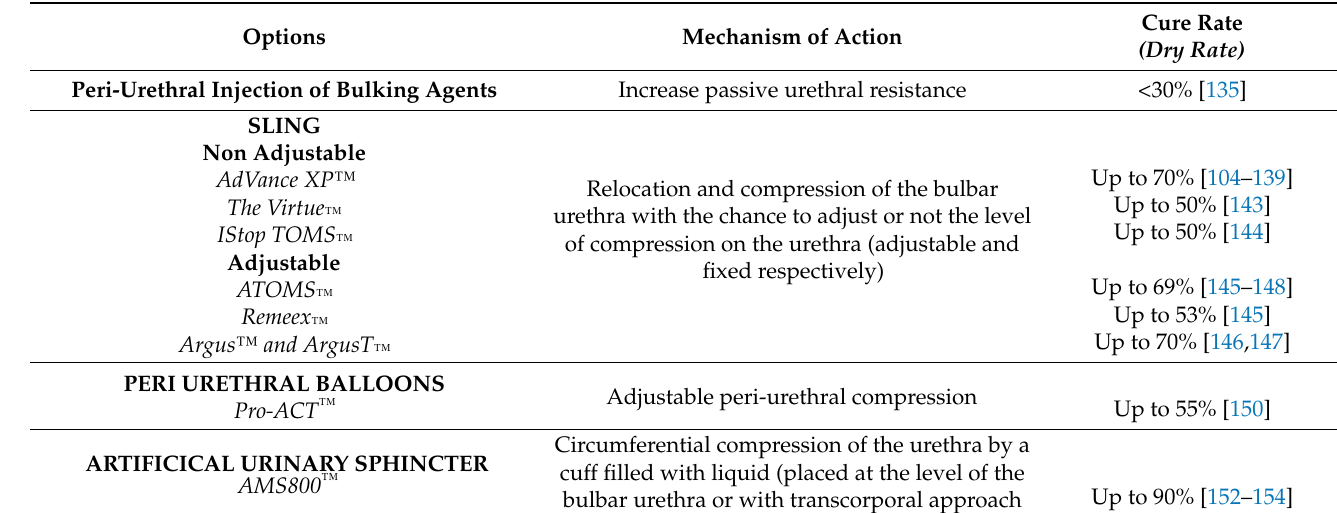
Table 2. Mechanism of action and cure rate of surgical treatment options for